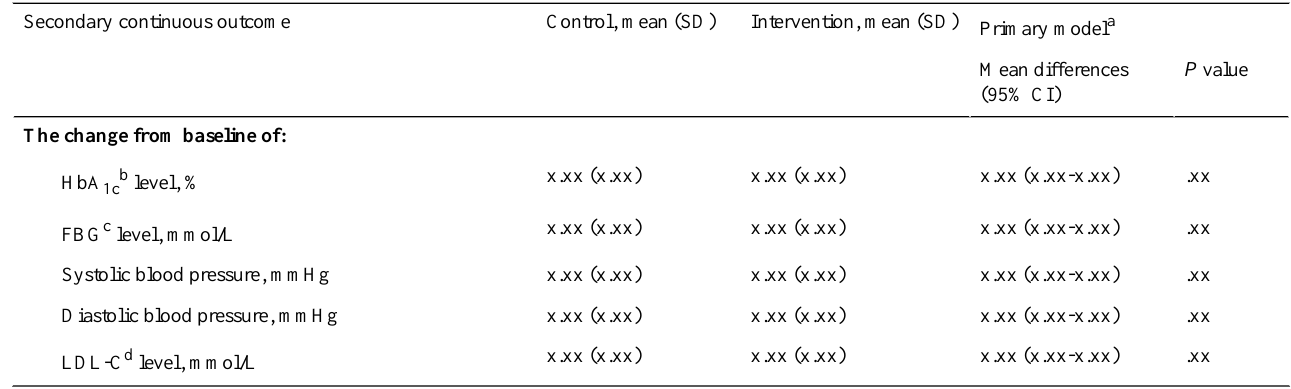
Primary model a Intervention, mean (SD)Control, mean (SD)Secondary continuous